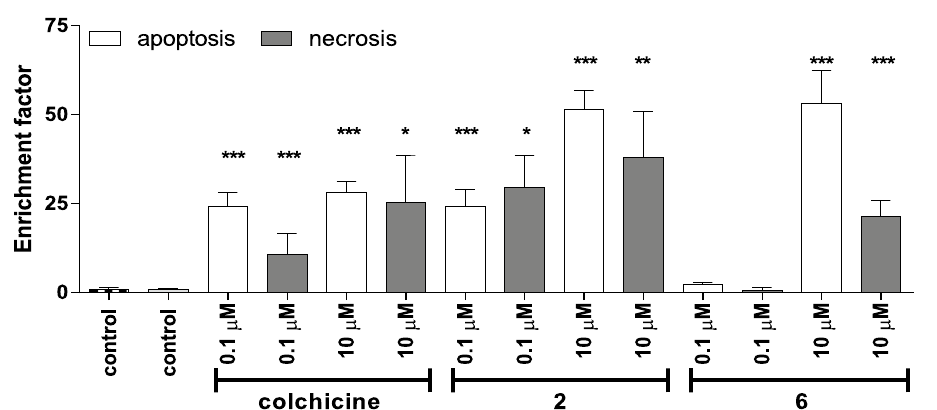
Figure 7. Effect of tested compounds: colchicine, 2 and 6 on apoptosis (white bars) and necrosis (grey bars) assayed using ELISA in SKOV-3 cells after 24 h of incubation. Statistical significances are marked with asterisks (*) p < 0.05; (**) p < 0.01; (***) p <